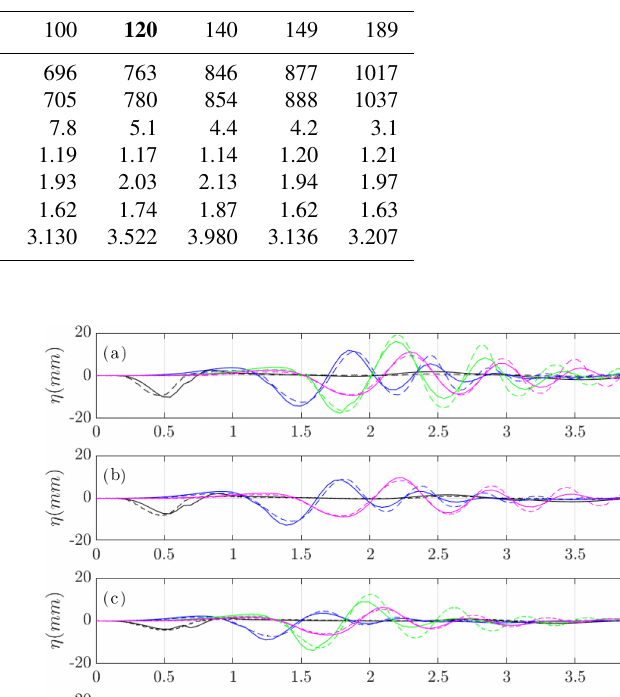
Table 4. Measured and curve-fitted slide and wave parameters for the seven experiments performed by Enet and Grilli (2007). Measured characteristic amplitude: η 0 (at x = x 0 ). Slide kinematics parameters: a 0 ,u t , and t 0 . The experiments marked in bold correspond to the two cases proposed by the NTHMP and used as main references in the present work (see text).